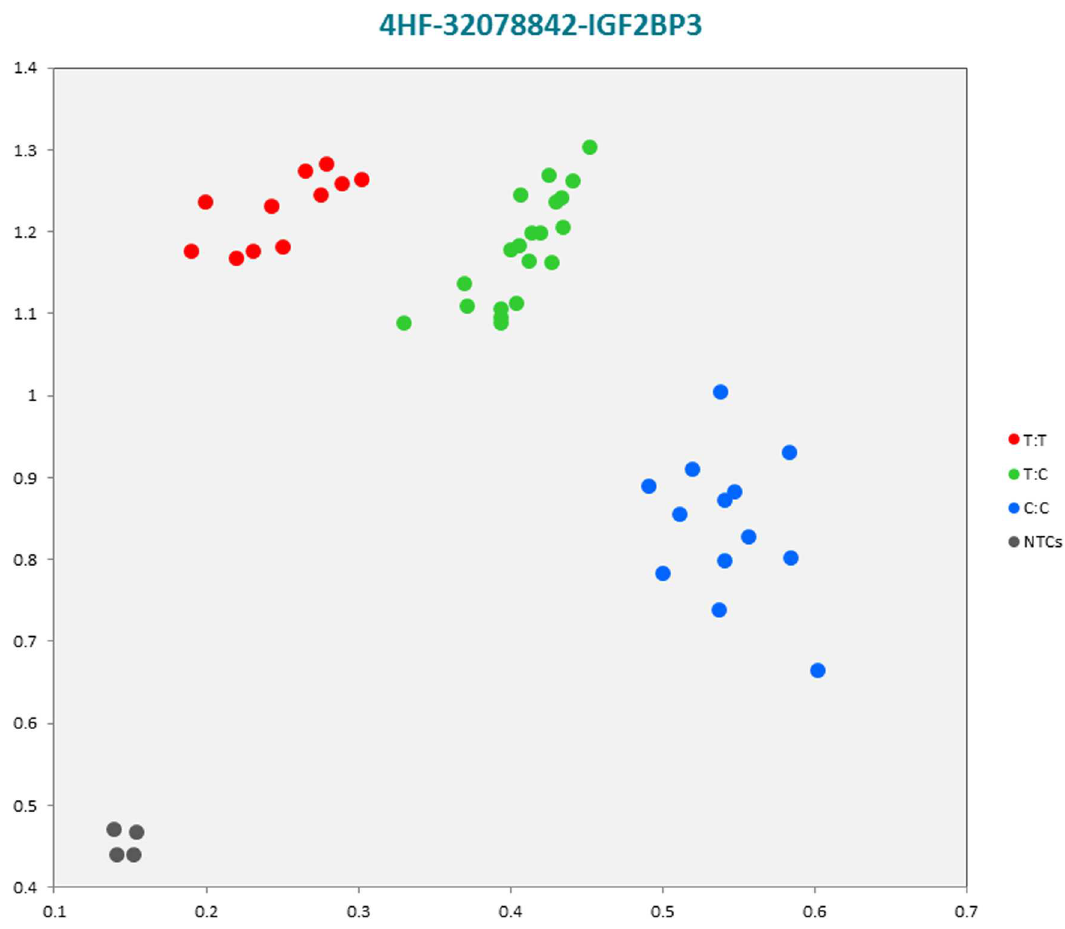
Fig 7. KASP TM SNP genotyping assay of BTA4_32078842locus of Polish HF IGF2BP3 gene showing the data for single KASP TM assayson a single cluster